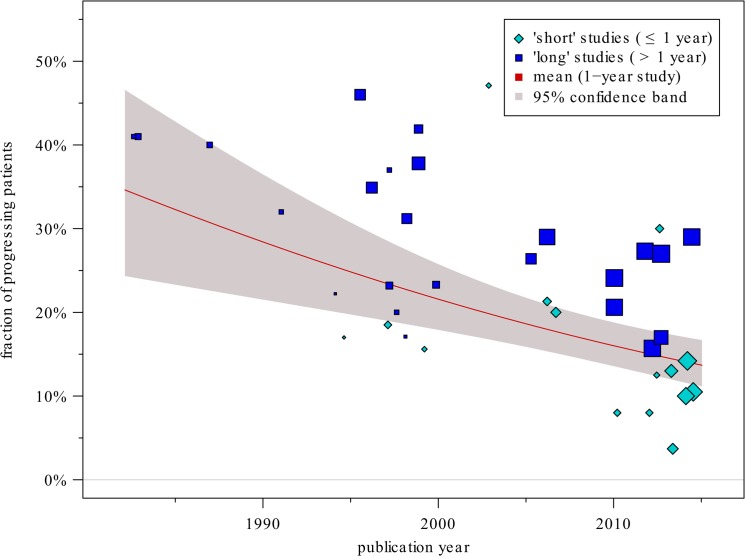
The fractions of patients with progressing EDSS status over the years.The chances of progression also depend on the study duration (you can see that shorter studies have smaller fractions) but even after accounting for the duration, the decreasing trend remains statistically significant (p<0.0001). The red line shows the estimated regression line for a trial duration of 1 year.